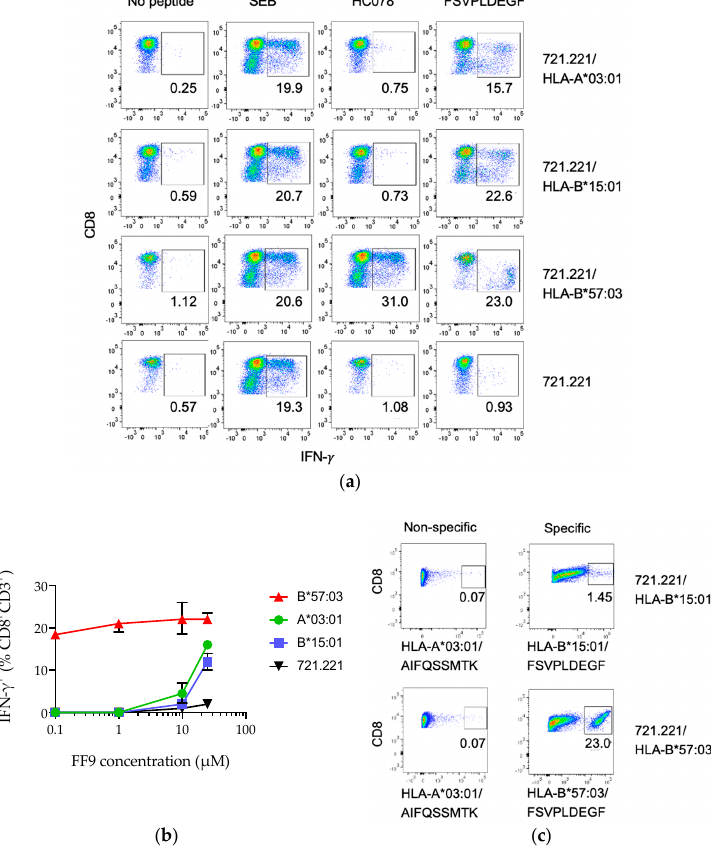
Figure 4. HC078-expanded STCL derived from volunteer 873 recognized FSVPLDECF (FF9) in the context of three HLA alleles. ( a ) PBMC of volunteer 873 expanded using HC078